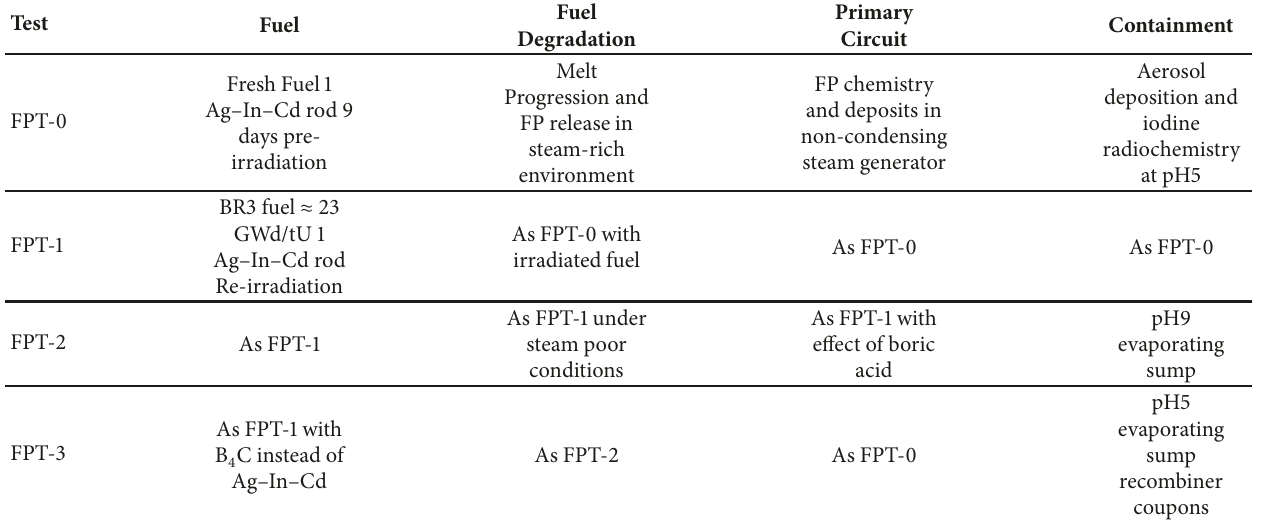
Table 1: Main characteristics of the different Ph´ebus tests with a solid fuel bundle.